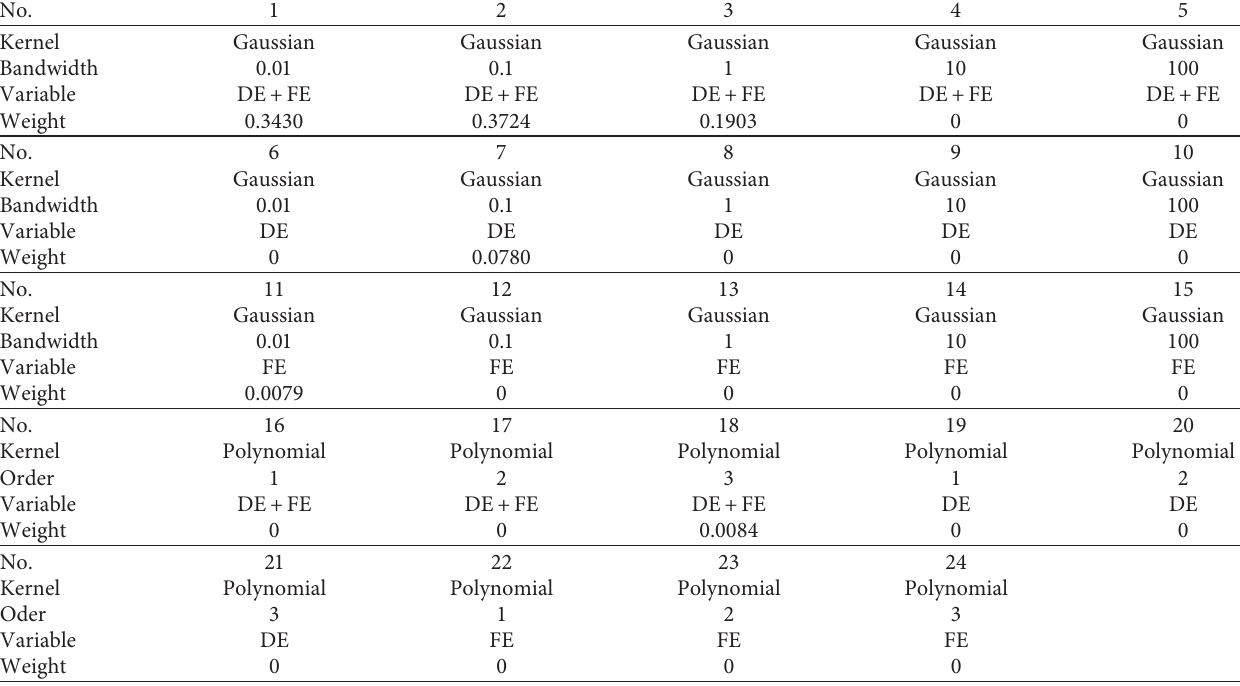
Table 4: Multikernel parameters for coaxial signals model.